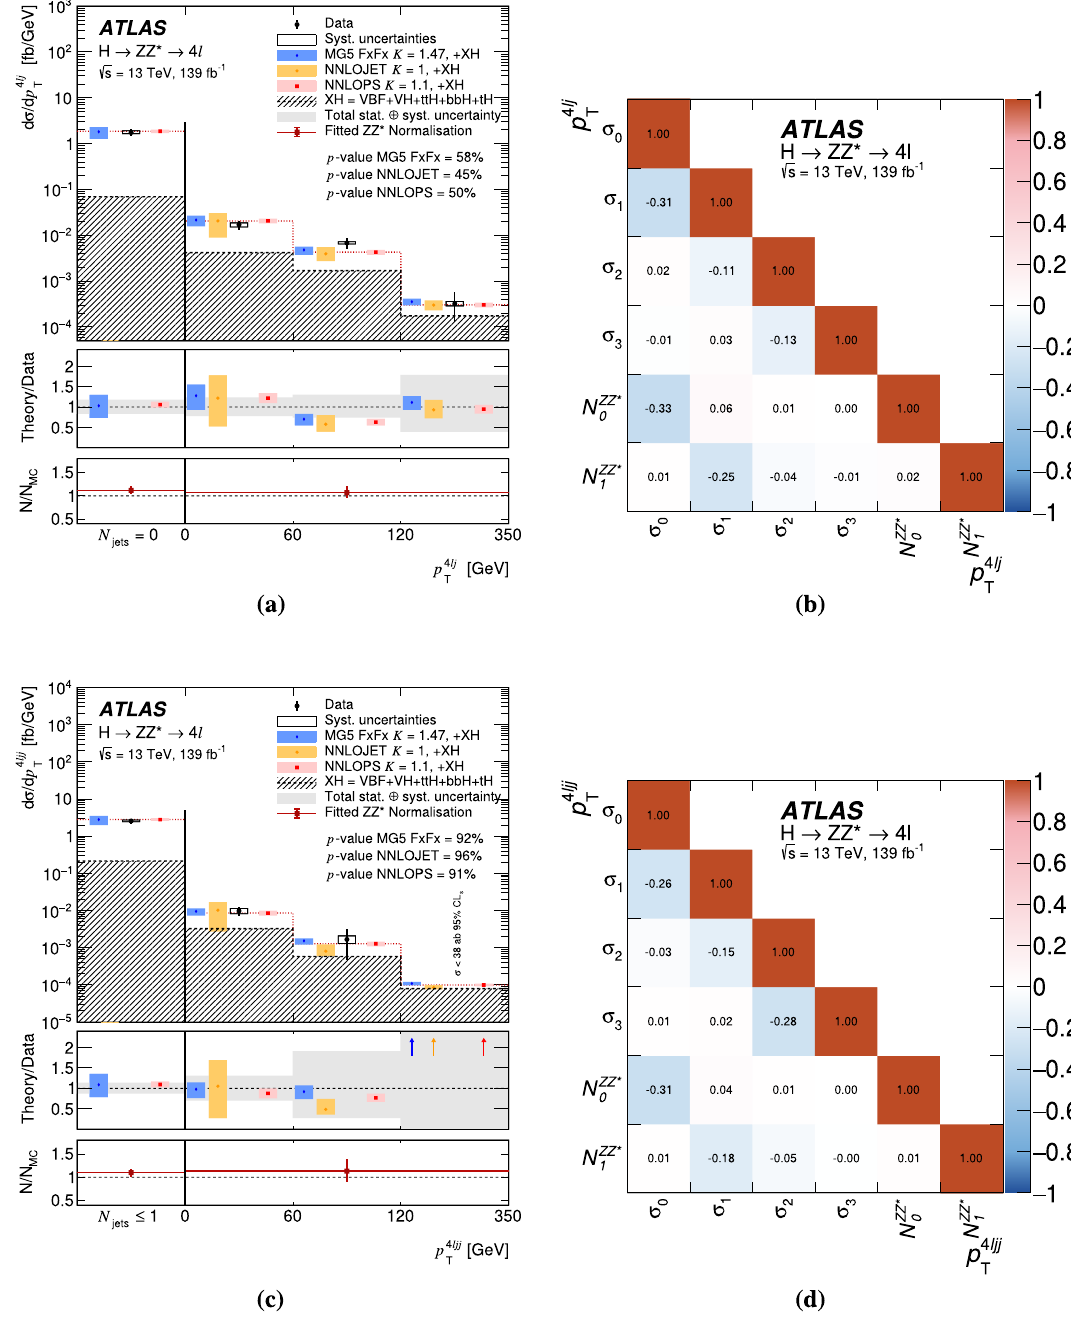
Fig. 29 Differentialfiducialcrosssectionsfor a thetransversemomen- tum of the four-lepton plus jet system, in events with at least one jet, and c the transverse momentum of the four-lepton plus dijet system,